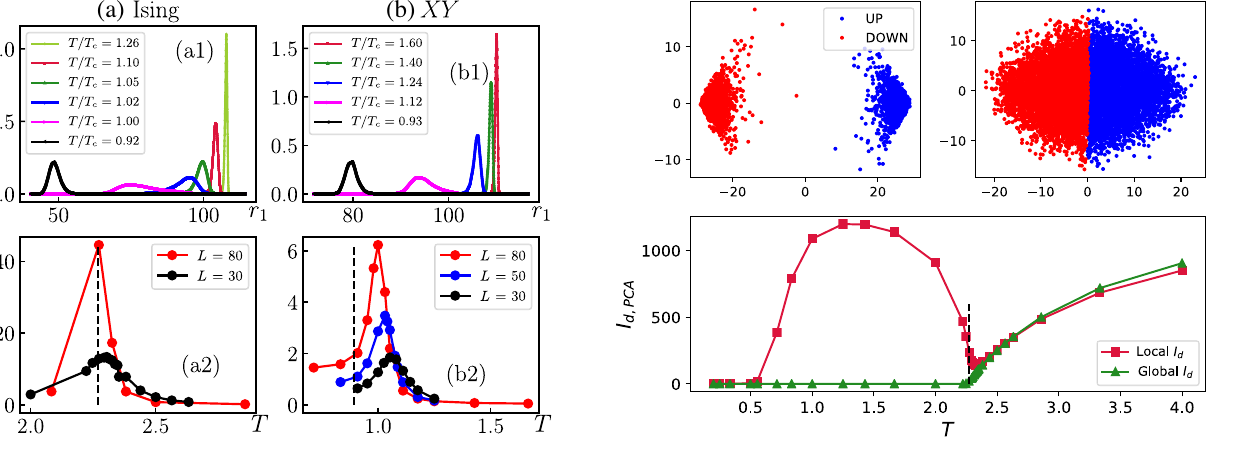
FIG. 6. Statistics of first nearest-neighbor distances, r 1 . In panels (a1) and (b1), we show the kernel density estimation of the probability density function of r 1 for the Ising and XY data sets, respectively. All the results have L ¼ 80 . Panels (b1) and (b2) show the temperature dependence of the variance associated with the distribution functions from panel (a) for different system sizes. Results for the second nearest-neighbor distances, r 2 , are qualitatively the